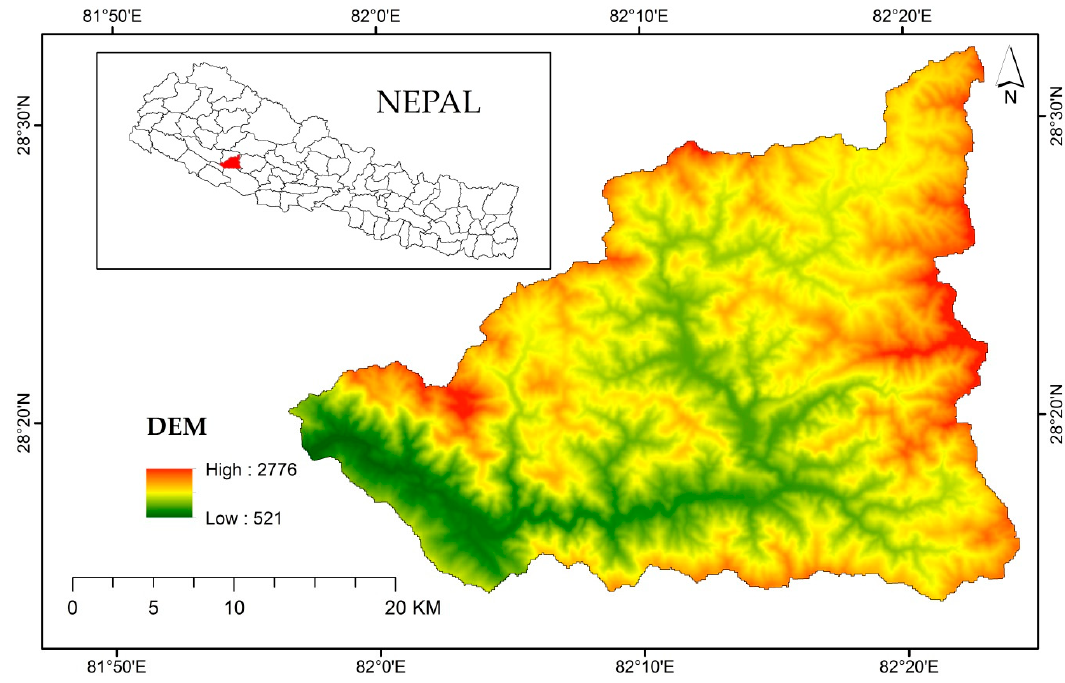
Figure 1. Study area with the Digital Elevation Model (DEM) .